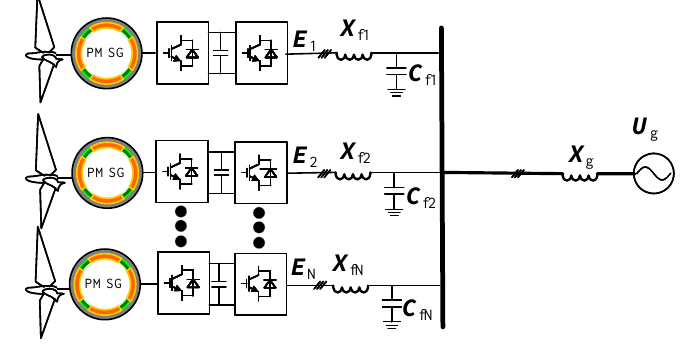
Figure 2. A weak AC system connected with N